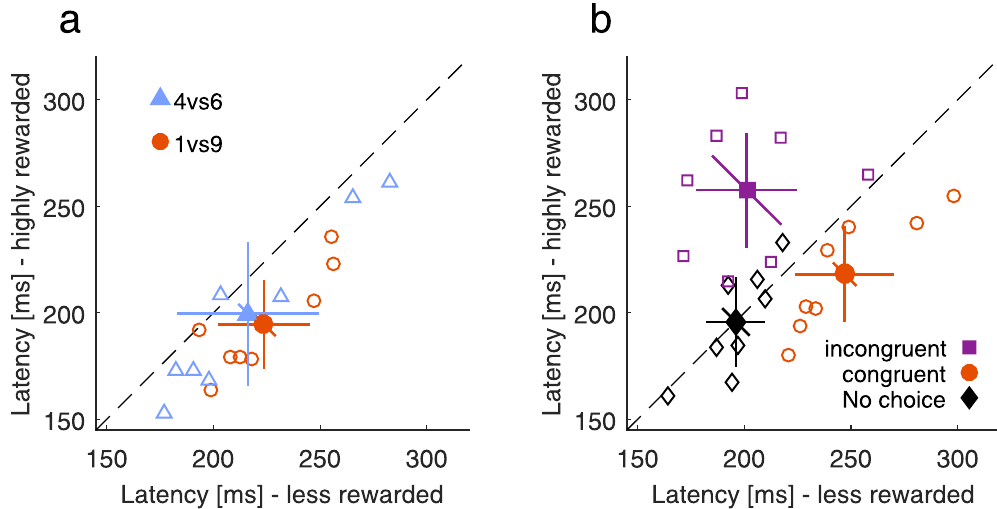
Figure 2. Latency delays are caused by choice-trials. ( a ) Results of Experiment 2. Single-trial latency for the highly versus less rewarded target when saccade frequency is equated for both hemifields. Open markers denote individual data and filled markers denote the mean with 95% confidence intervals. Diagonal error bars represent the error of the differences between high and low reward and have to be compared to the identity line. ( b ) Results of Experiment 3. Single-trial latency towards the highly compared to the less rewarded target when the reward in choice-trials was congruent (orange circle), incongruent (purple square) or without choice-trials (black